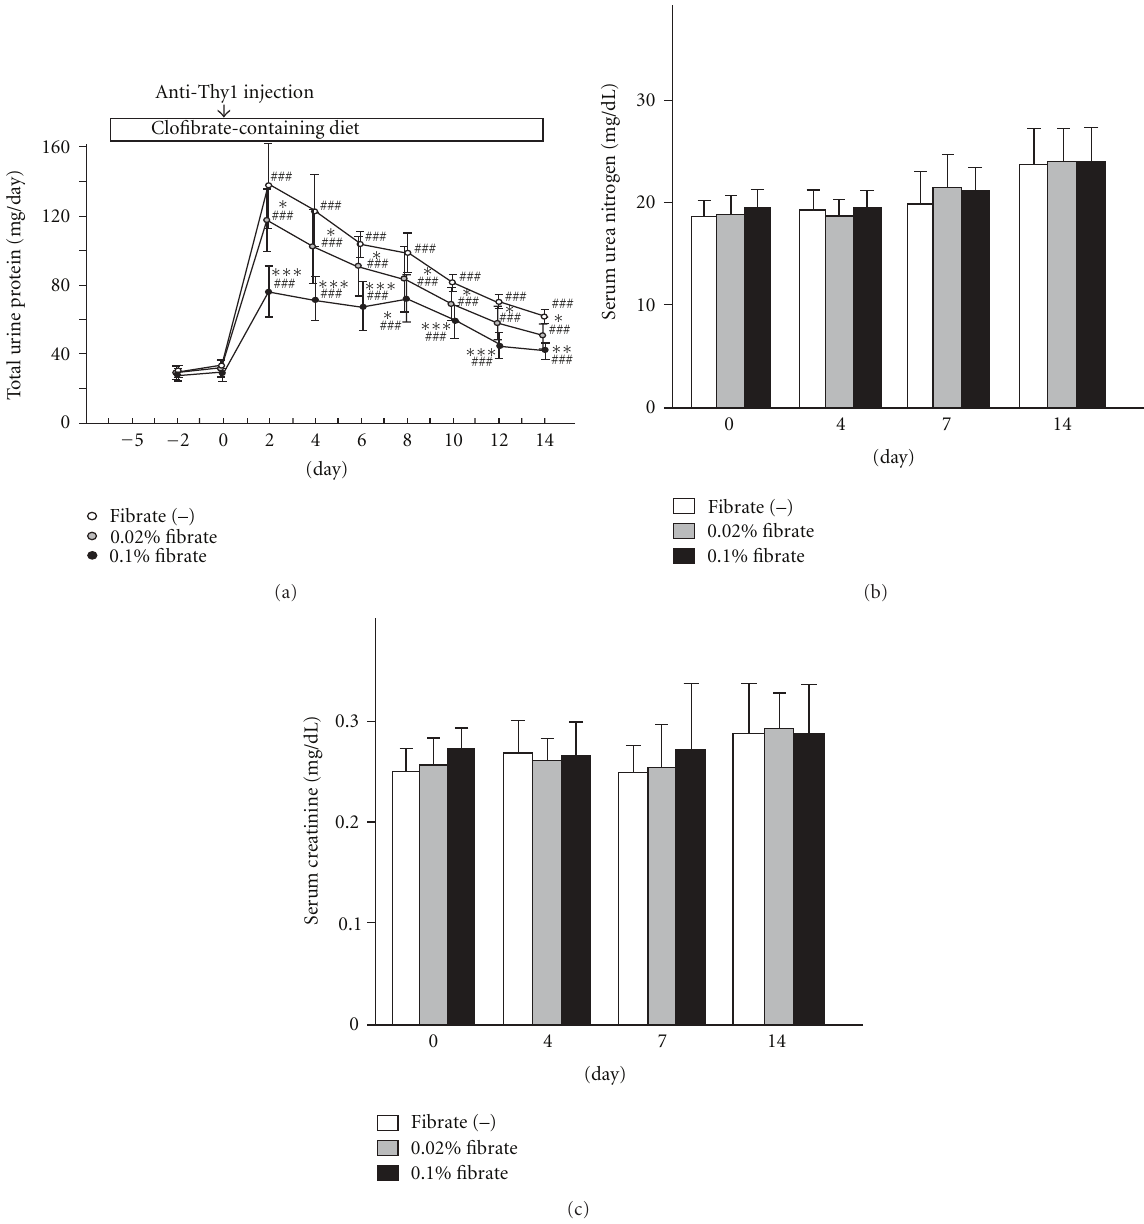
Figure 1: Alteration of kidney function by clofibrate pretreatment in anti-Thy1 nephritis rat. (a) Time course of the daily urinary protein excretion in anti-Thy1 nephritis rats. ((b) and (c)) Serum concentrations of urea nitrogen and creatinine, respectively. The clofibrate- pretreatment group was fed a 0.02% or 0.1% clofibrate-containing diet from 5 days before anti-Thy1 antibody injection. The start time of the anti-Thy1 antibody injection was designated as day 0. Values represent means ± SD ( n = 24, 12, and 24 for the Fib( − ), 0.02% fibrate, and 0.1% fibrate groups, resp.). Significant di ff erences from the respective day 0 groups are indicated with number signs (### P < 0 . 001), while significant di ff erences between regular-diet and clofibrate-diet groups are indicated with asterisks ( ∗ P < 0 . 05, ∗∗ P < 0 . 01, ∗∗∗ P < 0 . 001). nitrogen and creatinine were prone to increase in all groups; however, there were no significant di ff erences among the three groups. These findings suggest an antiproteinuric e ff ect of clofibrate treatment against anti-Thy1